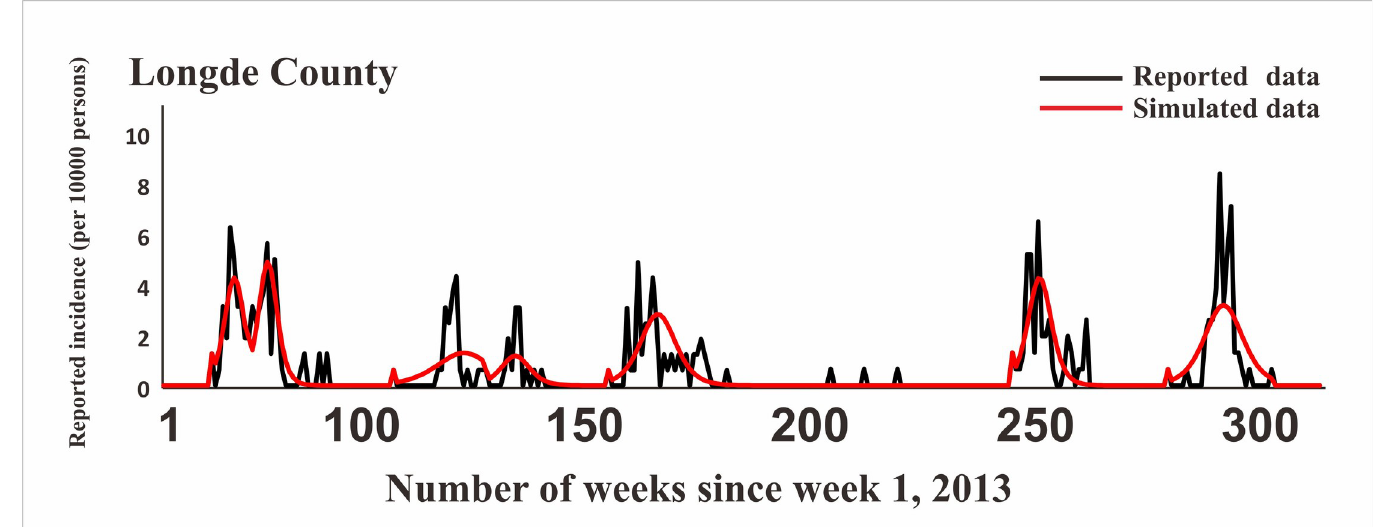
Fig 11. Epidemics of HFMD and LDE model fittings within Longde County.